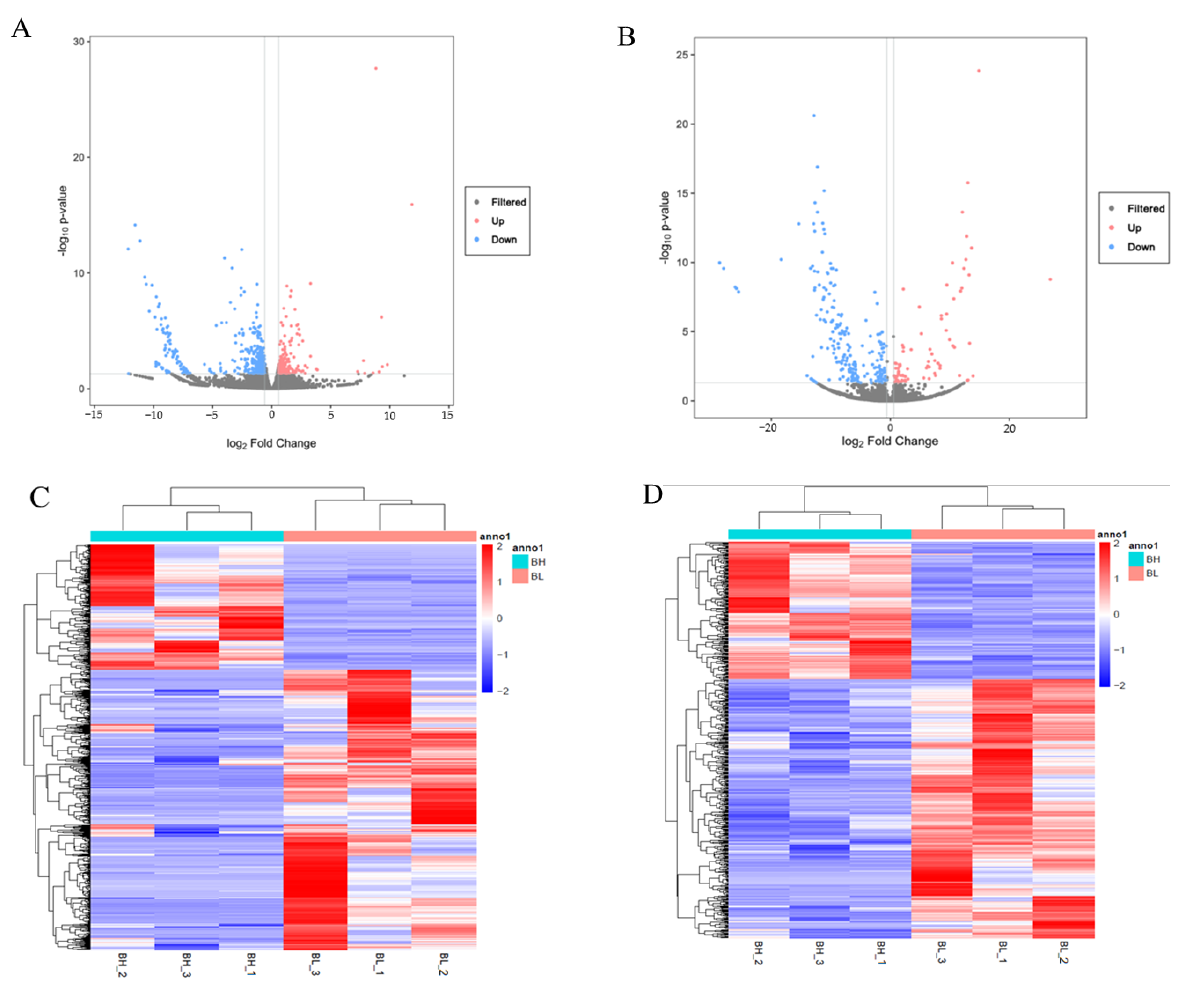
Figure 2. Expression profiles of distinct RNAs in backfat. ( A ) Volcano plots of DEGs; ( B ) Volcano plots of DELs; ( C ) Heatmap of DEGs; ( D ) Heatmap of DELs.